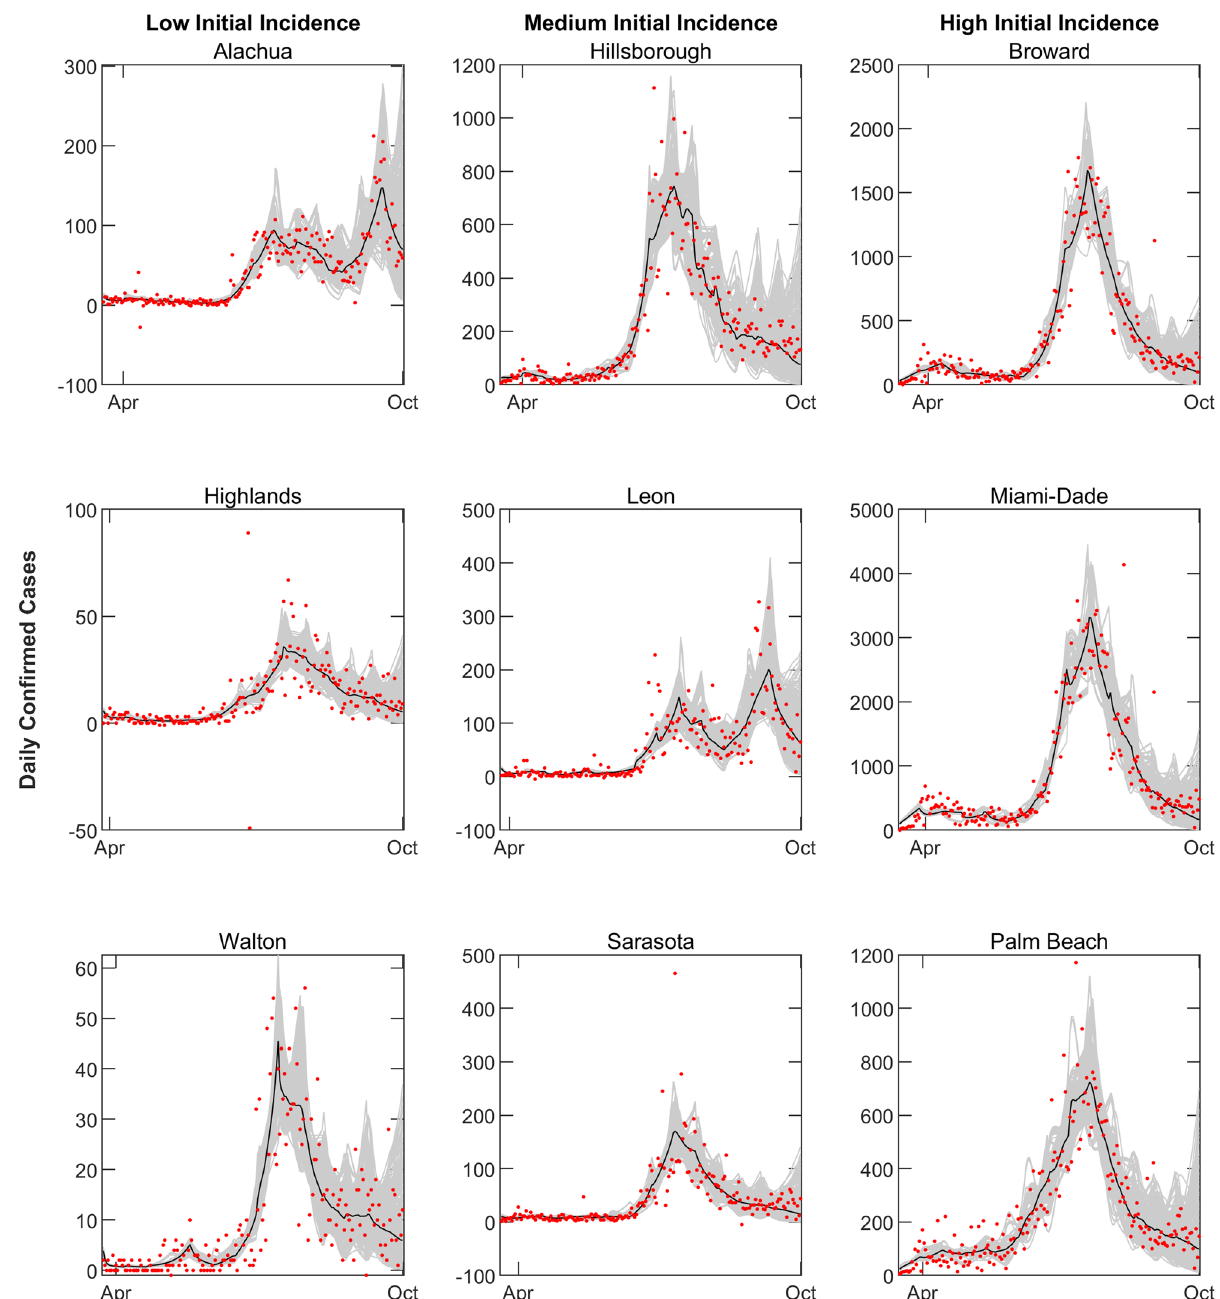
Figure 1. Model fits compared to confirmed daily case data in 9 representative Florida counties. Gray curves represent county-specific model predictions and red points represent confirmed case data obtained from Johns Hopkins University 47 . Fitting was started after at least 10 confirmed cases were reported. Results from model fits to representative countries, stratified by initial incidence growth rate in each county (Group a < 0.05, Group b > 0.05–0.15, Group c > 0.15) are shown. Group a counties: Alachua, Highlands, and Walton; group b: Hillsborough, Leon, and Sarasota; and group c: Broward, Miami-Dade, and Palm